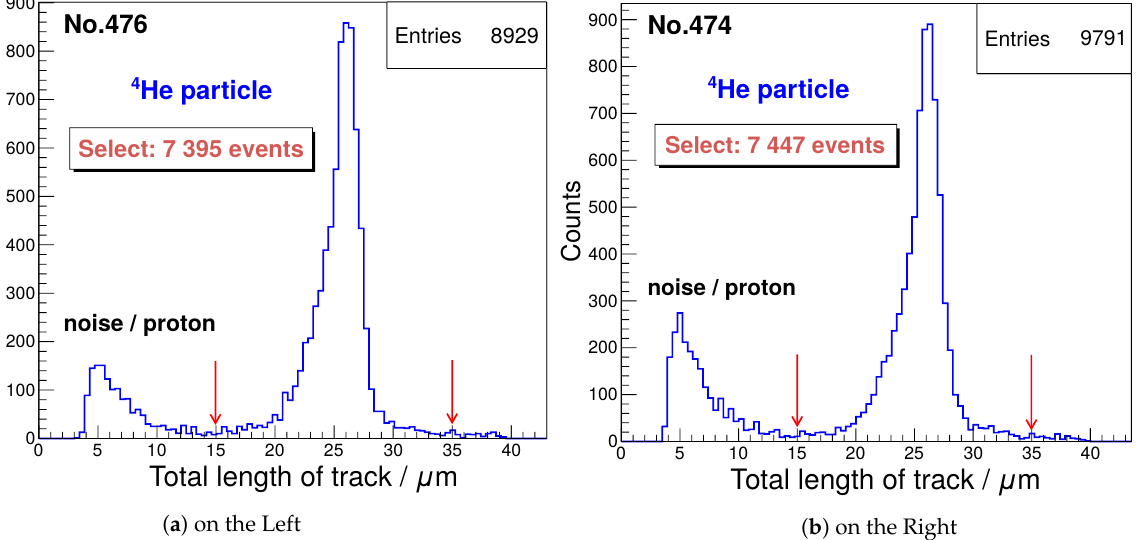
Figure 10. Comparison of spectra of track profile on the Left and Right of the polarimeter in a range of polar angle between 40 ◦ and 75 ◦